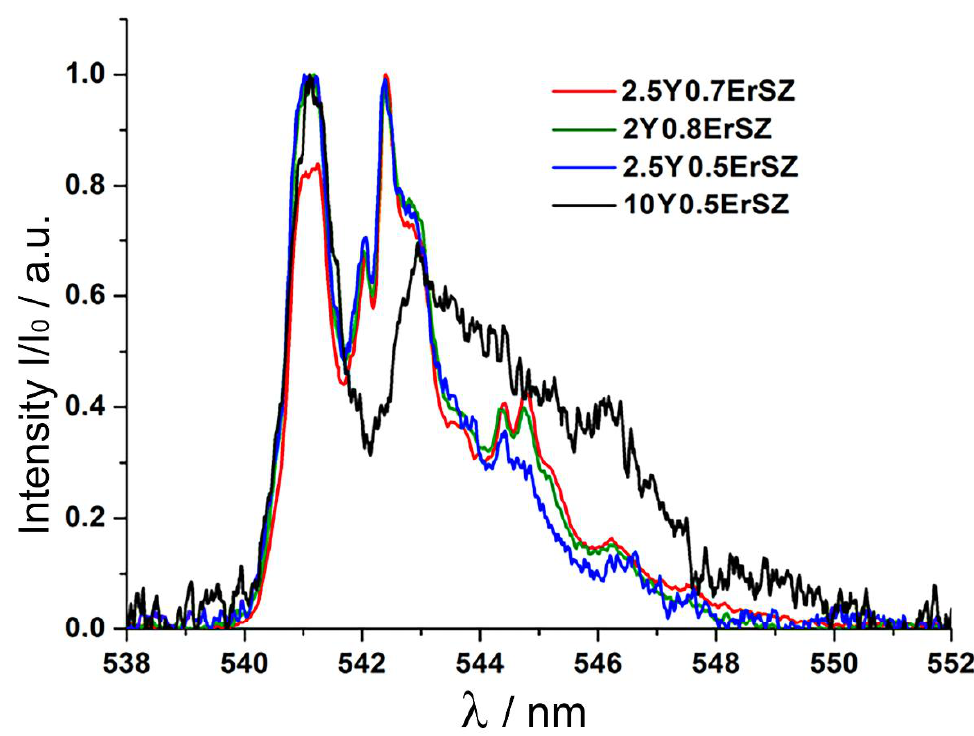
Figure 3. Absorption spectra of the 2Y0.8ErSZ, 2.5Y0.5ErSZ and 2.5Y0.7ErSZ crystals corresponding to the transition from the main multiplet 4 I 15/2 to the excited multiplet 4 S 3/2 at T = 77 K.